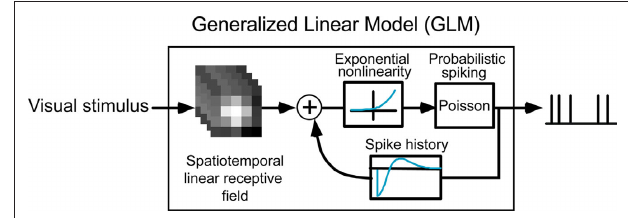
Figure 2 | The generalized linear model (gLM). See “Materials and Methods” for details.